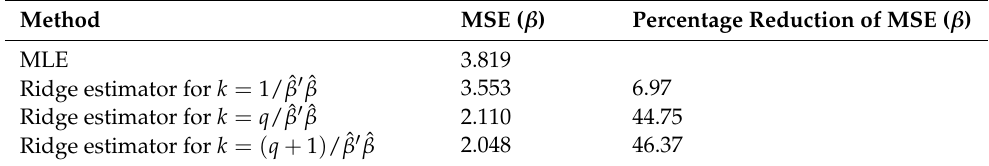
Table 6. Comparison of MSE in NFHS